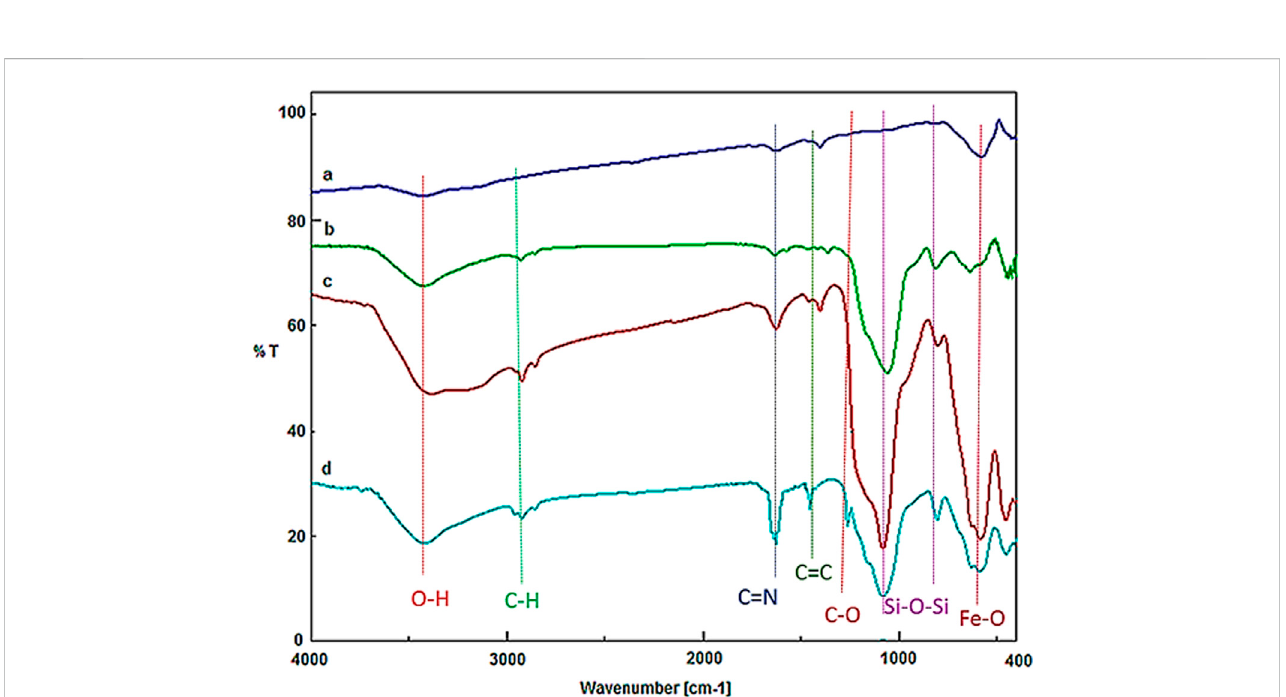
FIGURE 2 FT-IR of (A) Fe 3 O 4 , (B) Fe 3 O 4 @PMO, (C) Fe 3 O 4 @PMO/Pr-NH 2 and (D) Fe 3 O 4